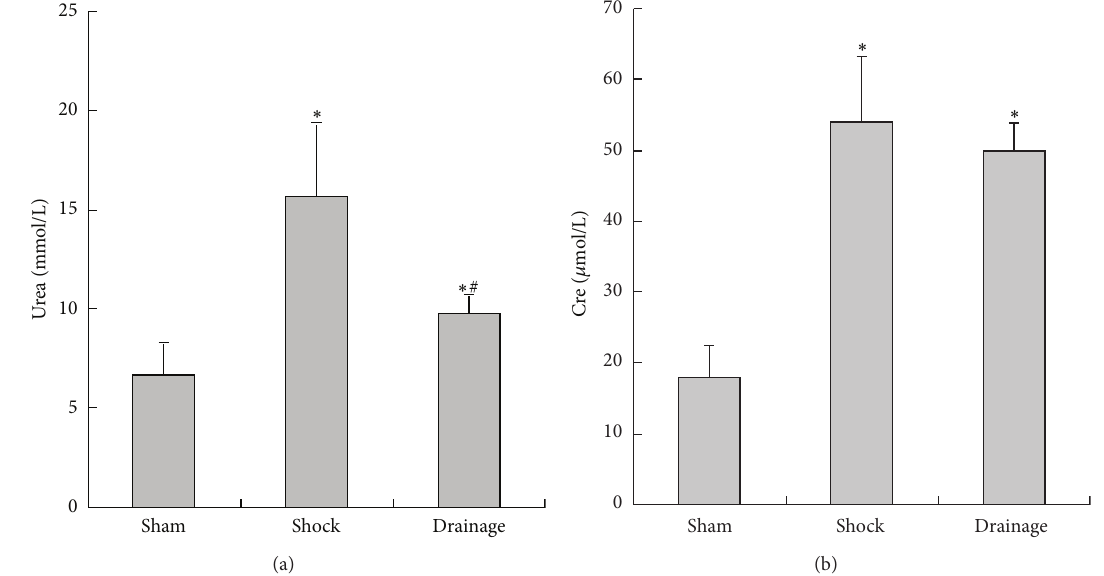
Figure2:Effectsofmesentericlymphdrainageonrenalfunctionindicesinhemorrhagicshockratswithoutresuscitation(mean ± SD, 𝑛 = 6 ). ∗ 𝑃 < 0.05 versus sham group; # 𝑃 < 0.05 versus shock